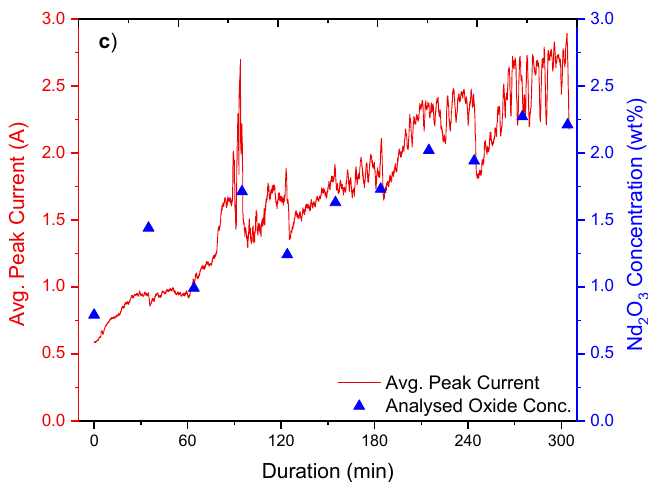
Figure 3. Data from the dissolution of Nd 2 O 3 in different compositions of NdF 3 –LiF electrolytes: ( a , b ) Nd 2 O 3 in an equimolar NdF 3 –LiF electrolyte as in experiments 1 and 2; ( c ) Nd 2 O 3 in 20/80 mol% NdF 3 –LiF electrolyte as in experiment 3.